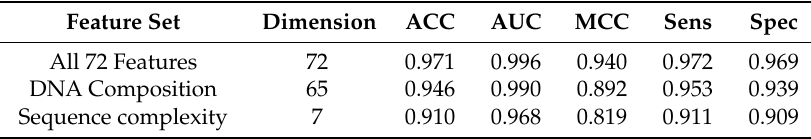
Table 3. Comparison of two groups of features using independent testing on